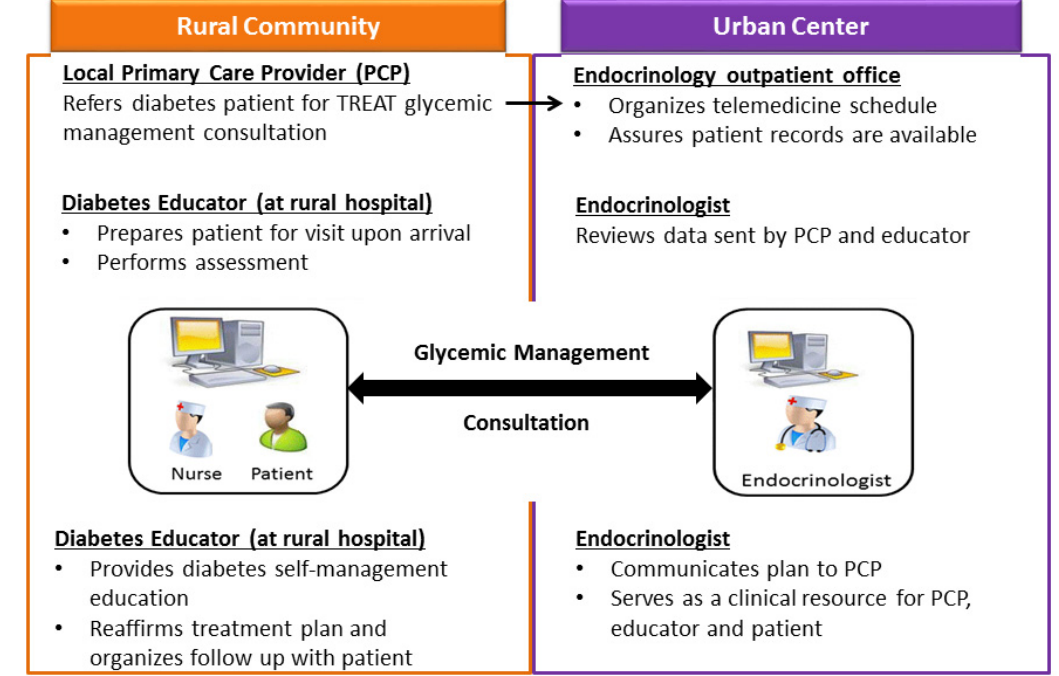
Figure 3. The telemedicine for reach, education, access and treatment (TREAT) glycemic management